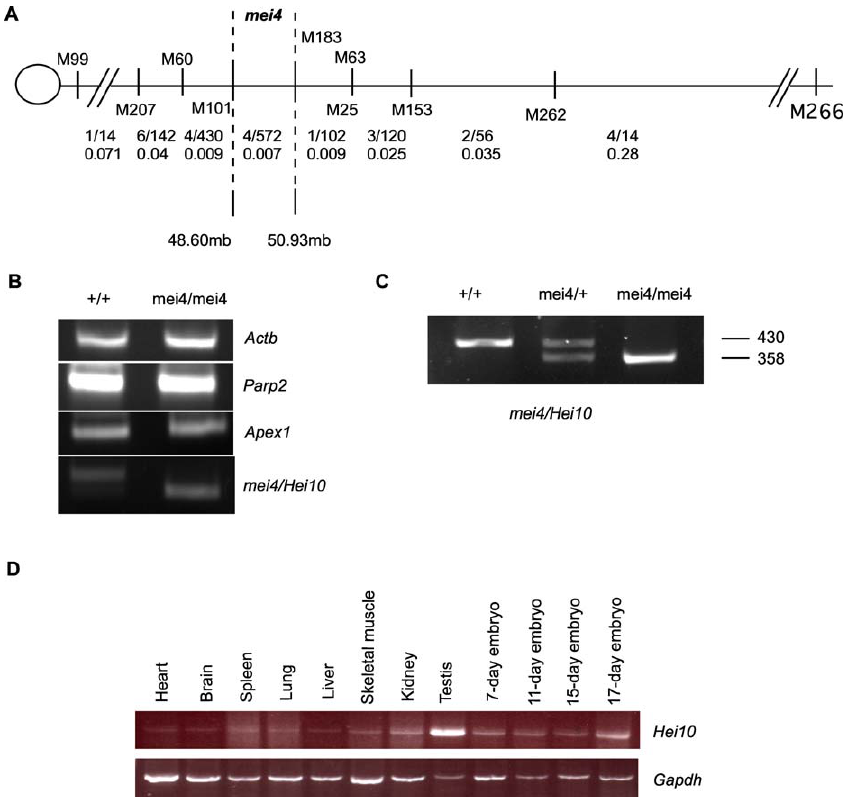
Figure 4. mei4 Maps to a 2.5-mb Region on Chromosome 14 and Is Associated with an Altered Hei10 Transcript That Is Expressed Prominently in the Testis and 17-d Embryo (A) The diagram shows microsatellite loci abbreviated with ‘‘ M ’’ for D14Mit. To map mei4 genetically, intersubspecific intercrosses were set up between animals heterozygous for mei4 . The number of meioses scored for recombinants in particular intervals are indicated in raw numbers (# of recombinants/ # of meioses) and recombination fractions. The data placed mei4 in a 0.7-cM region corresponding to a physical distance of ; 2.5 mb. (B) RT-PCR was performed on total RNA isolated from normal ( þ / þ ) and mutant ( mei4/mei4 ) animals. Neither Parp2 nor Apex1 showed altered transcript amount or size (rows 2 and 3, respectively). The Hei10 transcript is expressed at similar levels in þ / þ and mei4/mei4 but displays altered mobility in agarose gel electrophoresis (row 4). Similar b-Actin ( Actb ) expression in both þ / þ and mei4/mei4 indicates equal RNA amounts (row 1). (C) RT-PCR of þ / þ , mei4/ þ , and mei4/mei4 animals. The þ / þ (lane 1) displays the expected 430-bp band, whereas the mei4/ þ (lane 2) displays both the expected size band and a smaller band (358 bp) that is identical in size to the only band in the mei4/mei4 sample (lane 3). (D) A mouse cDNA panel was used to determine the expression pattern of Hei10 across a range of tissues. Expression relative to the GAPDH control was highest in testis and 17-d-old embryo. The 17-d-old embryo is a mixed male and female sample and represents the onset to midterm of prophase I